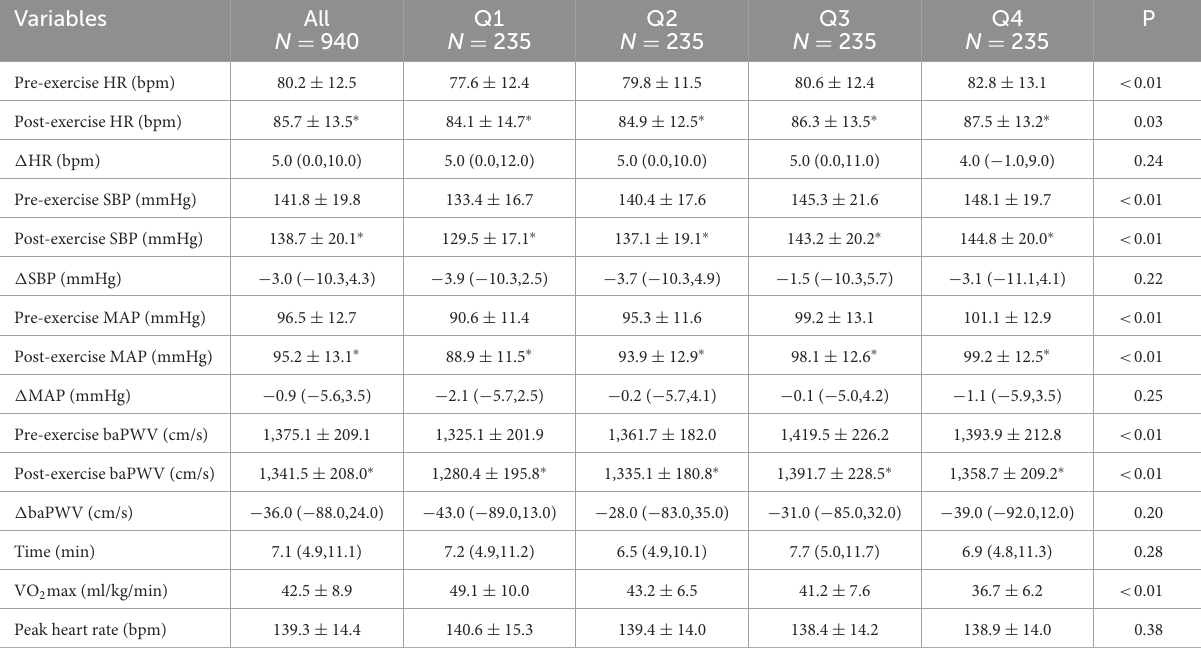
TABLE 2 Pre-exercise and post-exercise arterial stiffness and vessel hemodynamic parameters for participants with different BF%. Variables All N = 940